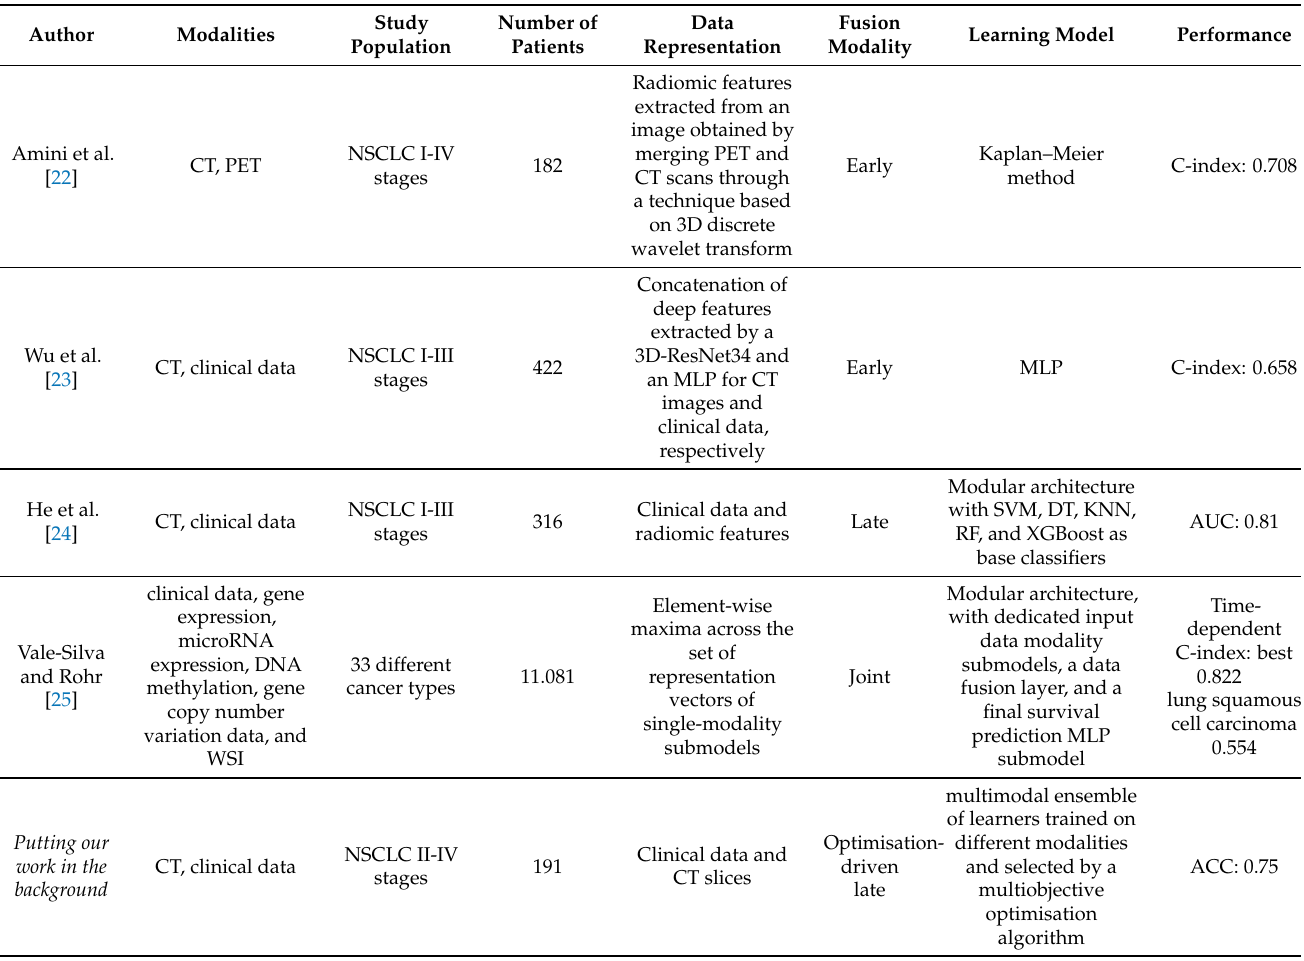
Table 1. Summary of the background on the multimodal learning to predict the overall survival in NSCLC. For the sake of completeness, the last section puts our contribution in the context of the